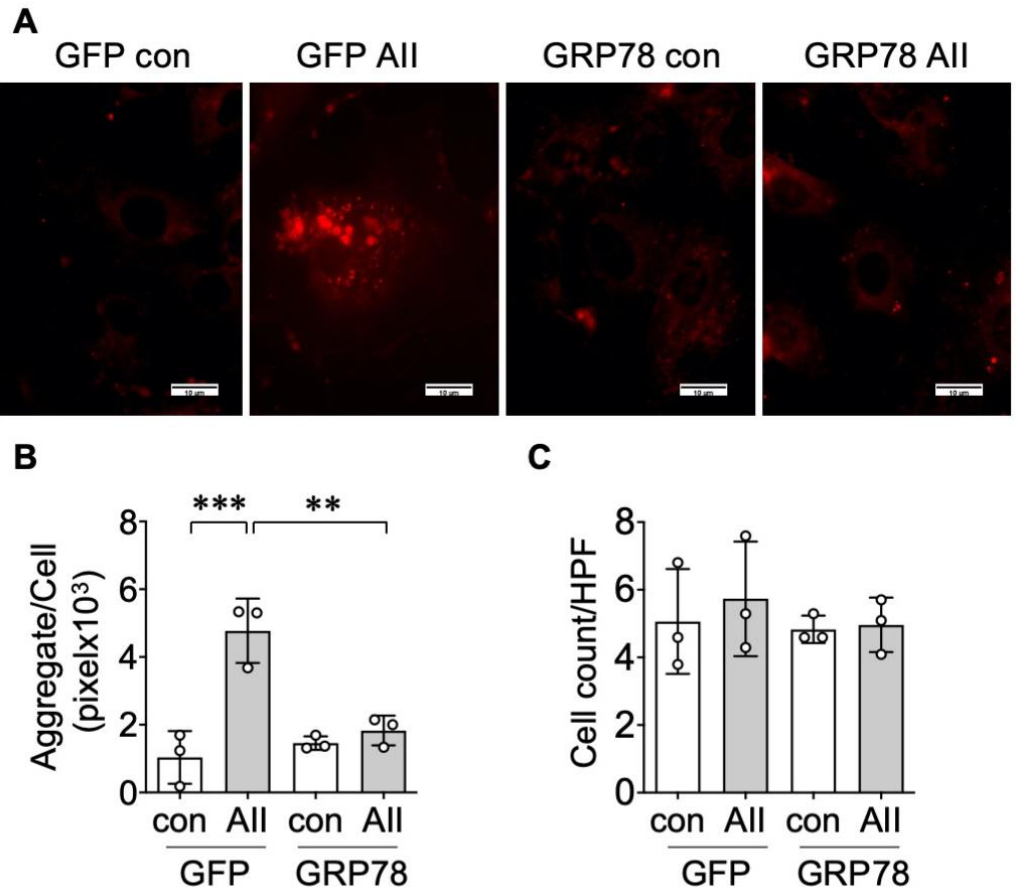
Figure 2. The transduction of 78 kDa glucose-regulated protein (GRP78) mitigates AngII-induced aggregate formation in VSMCs. ( A , B and C ) The rat aortic VSMCs infected with adenovirus encoding GRP78 or control green fluorescent protein (GFP) (100 multiplicity of infection (moi)) for 48 h were stimulated with 100 nM AngII (AII) for 48 h. Representative Proteostat staining images are shown. The scale bar indicates 10 μm. ( A ). The aggregate positive area per cell ( B ) and total attached cells ( C ) in HPF were evaluated with ImageJ software. The bars in the graphs show the mean ± SD from 3 independent experiments. ** indicates p < 0.01. *** indicates p < 0.001.